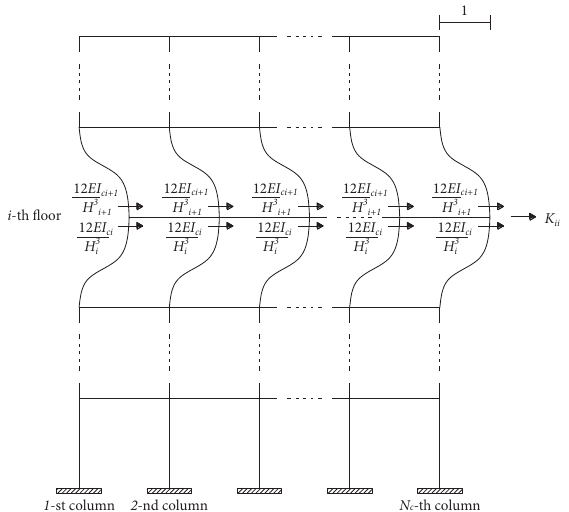
Figure 18: Scheme of the forces due to a unitary acceleration at the ( i )-th floor for computing the M ii term of the mass